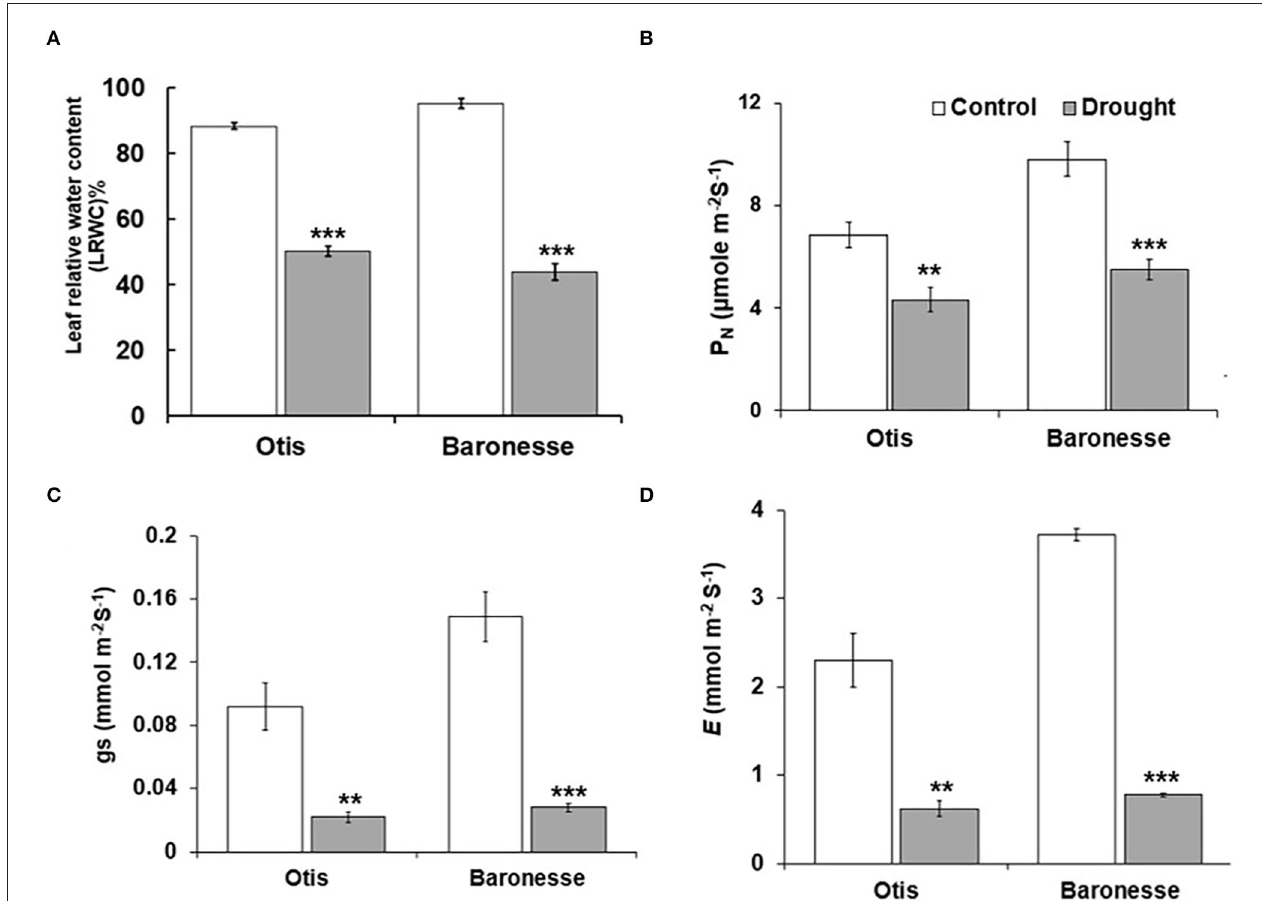
FIGURE 2 | Physiological changes in Otis and Baroness under drought. (A) LRWC. (B) Net photosynthetic rate (P N ). (C) Stomatal conductance (gs). (D) Transpiration rate ( E ). Values are the means of 10 plants for LRWC and 6 plants for photosynthesis measurements. Bars represent standard errors of the means. ** P < 0.01 and *** P <